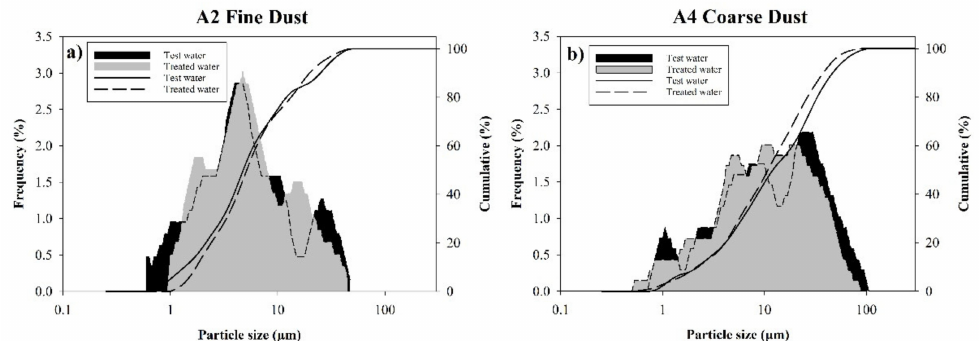
Figure 3. Particle distribution by size (%) and particle size weighted distribution (%) before/after Treatment; ( a ) A2 Fine Dust, ( b ) A4 Coarse Dust. Table 4. Percentile changes of Inoculated dust particle size ( µ m).